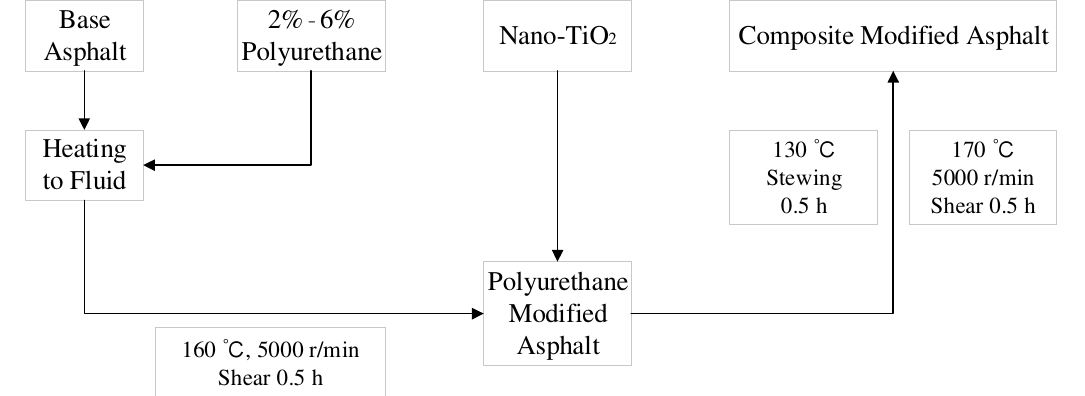
Figure 1. The preparation process of modified asphalt.